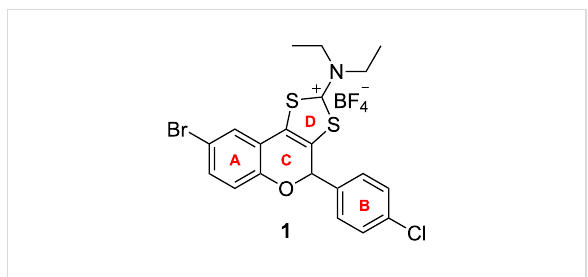
Figure 1: The molecular structure of tricyclic flavonoid 1